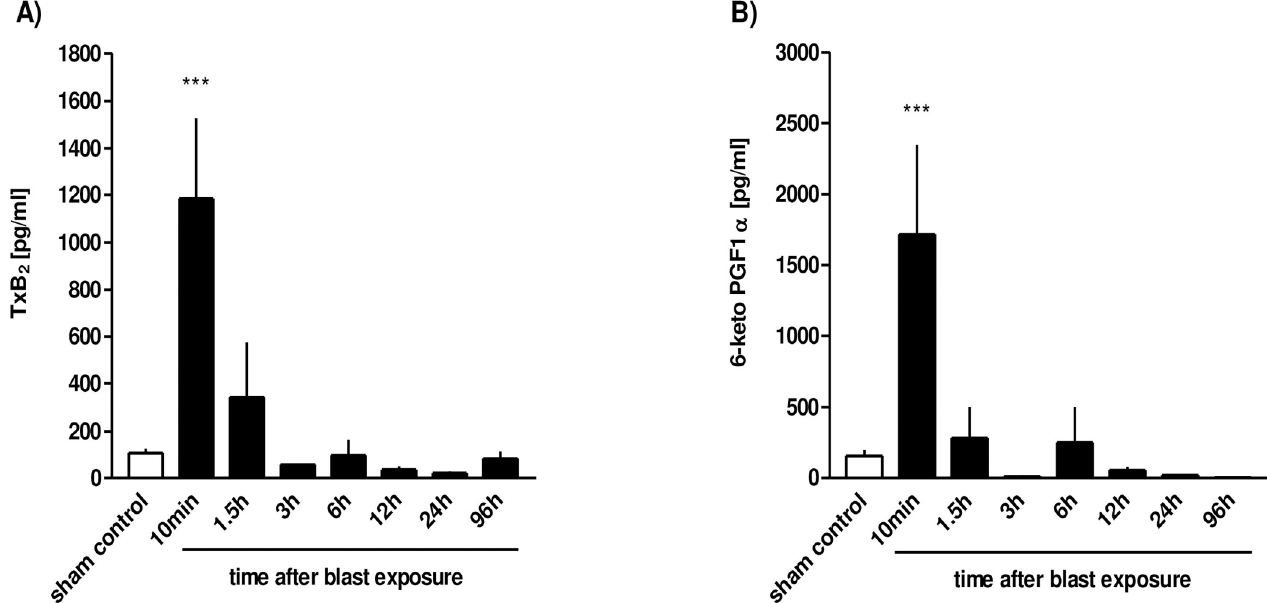
Fig 7. Prostanoid release in the early phase after thoracic trauma. The animals were sacrificed 10 min (n = 6), 1.5 h (n = 3), 3 h (n = 3), 6 h (n = 3), 12 h (n = 4), 24 h (n = 3) or 96 hours (n = 3) after blast exposure, non-traumatized animals served as sham controls (n = 9). A) TxB2 release and B) 6-keto PGF1 α were determined in BALFs. Data were analysed by one-way ANOVA and Tukey’s multiple comparison test. ��� p < 0.001: 10min vs. all other groups. Data represent means ± SEM, number of experiments (n) in parentheses.